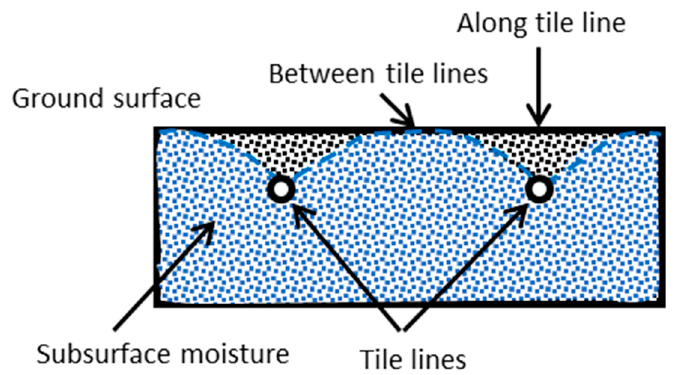
Figure 1. Conceptual diagram (cross-section) showing tile drainage and assumed subsurface mois- variation along and between tile lines (blue shading indicates water ture variation along and between tile lines (blue shading indicates water saturation).